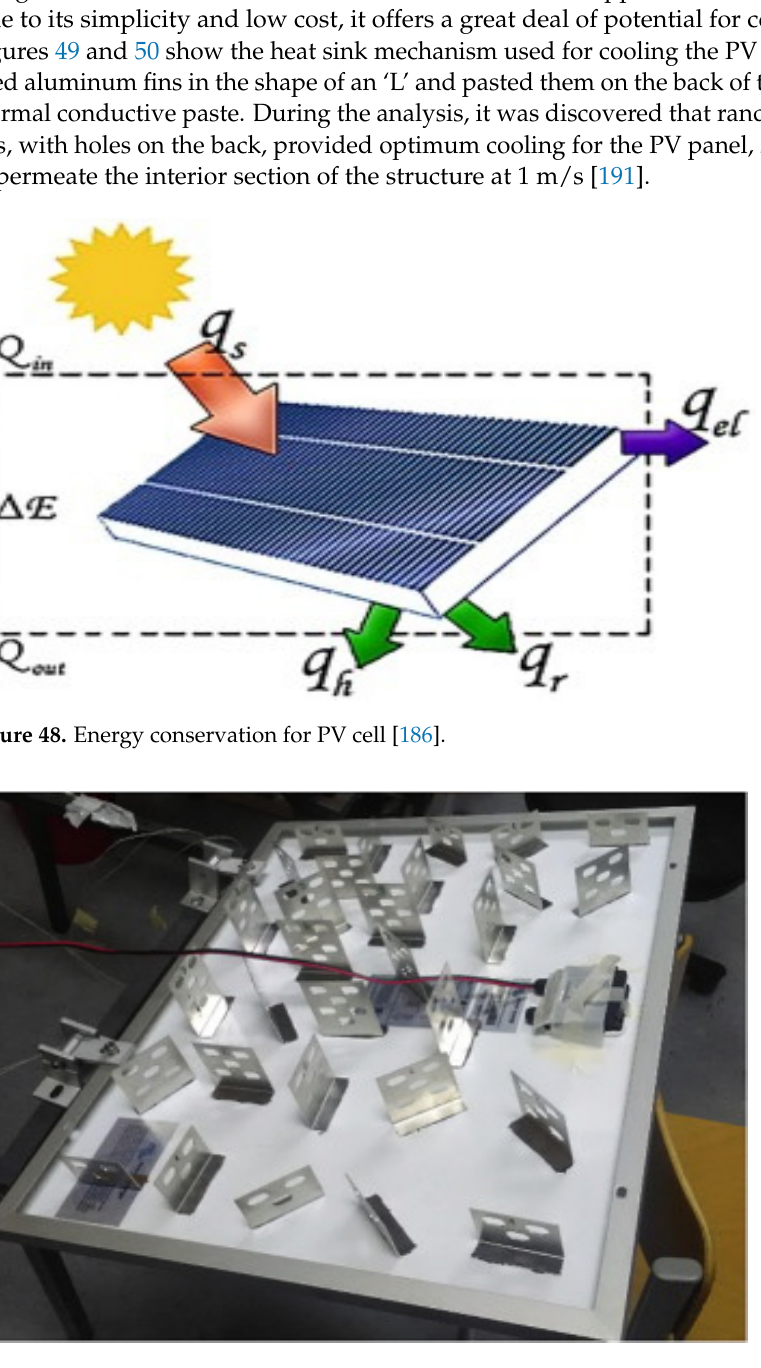
Figure 48. Energy conservation for PV cell [186].